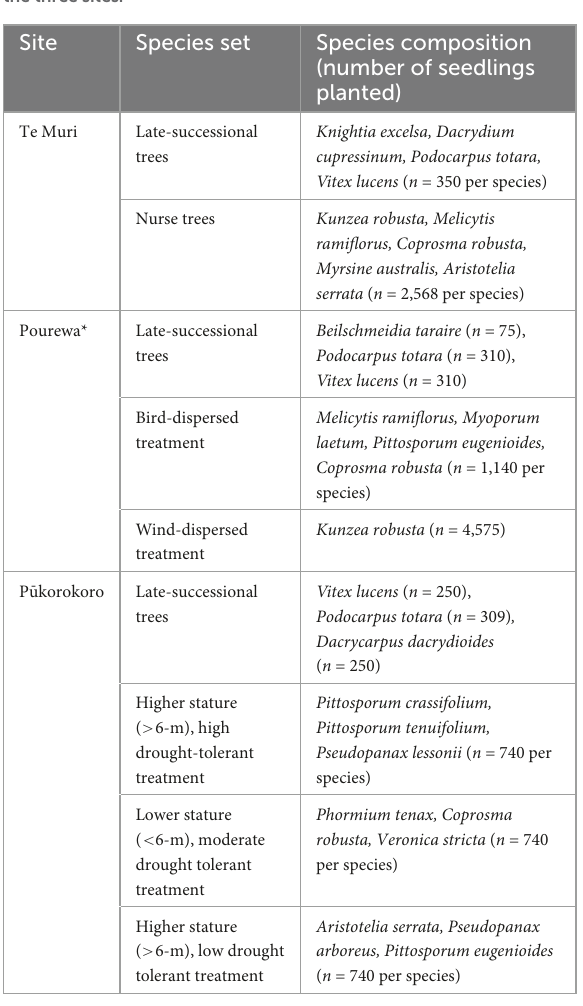
TABLE 2 Species composition of plantings and treatment designs at the three